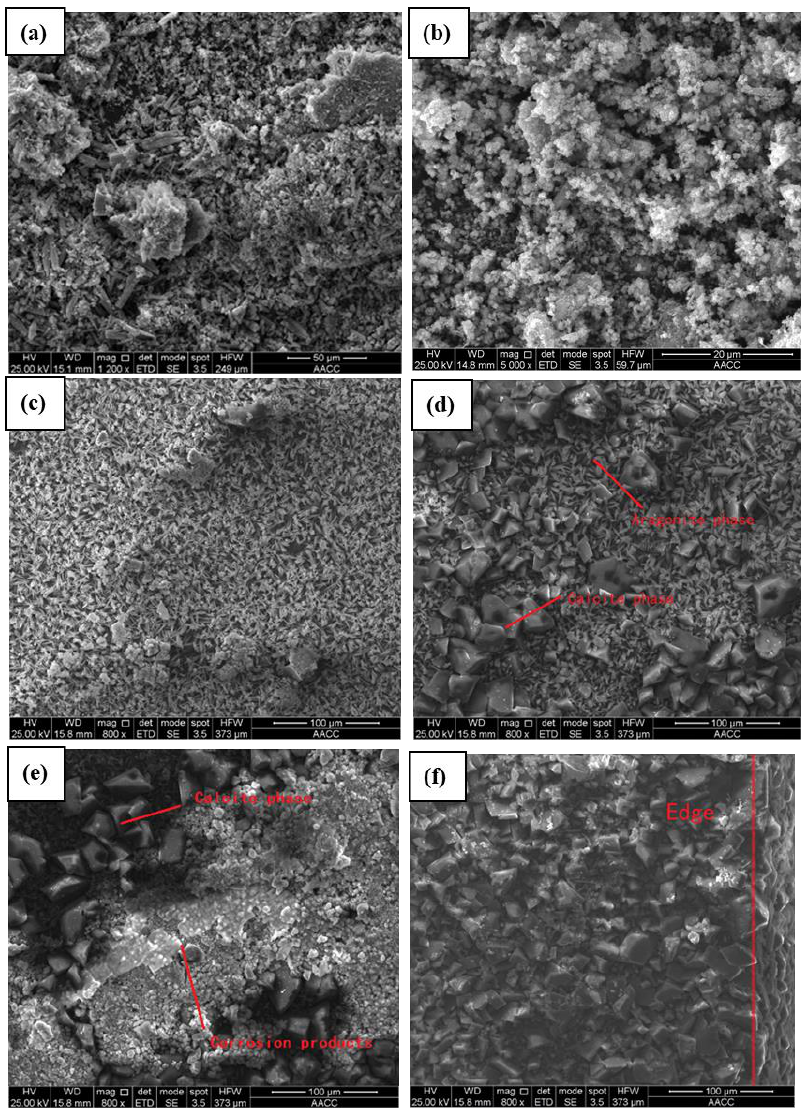
Figure 7. Surface morphology of the specimen after being fouled ( a , b ) uncoated specimen ( c – f ) specimen 1.